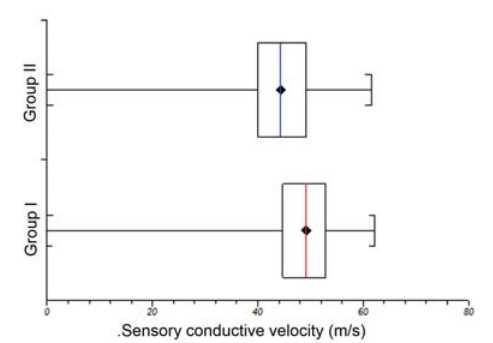
FIGURE 1. Sensory conductive velocity. Median value SCV for Group I was 49.15 m/s, and for Group II 44.35m/s. The difference was statistically signi fi cant (p<0.001).